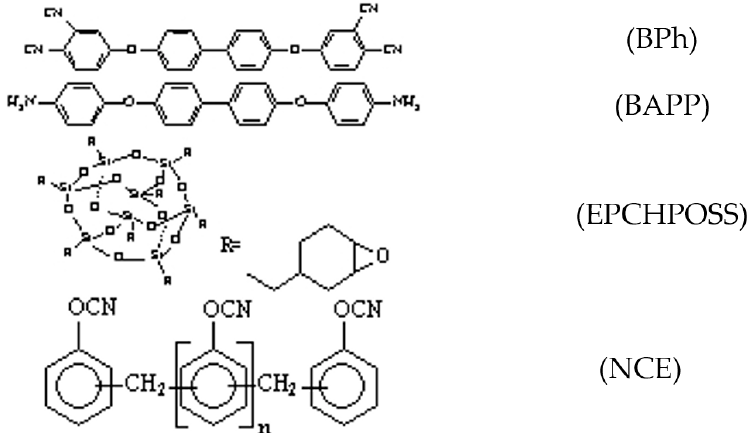
Figure 1. Structures of the phthalonitrile monomer, curing agent, phthalonitrile–polyhedral oligomeric silsesquioxane (POSS), and cyanate ester (NCE) used in this